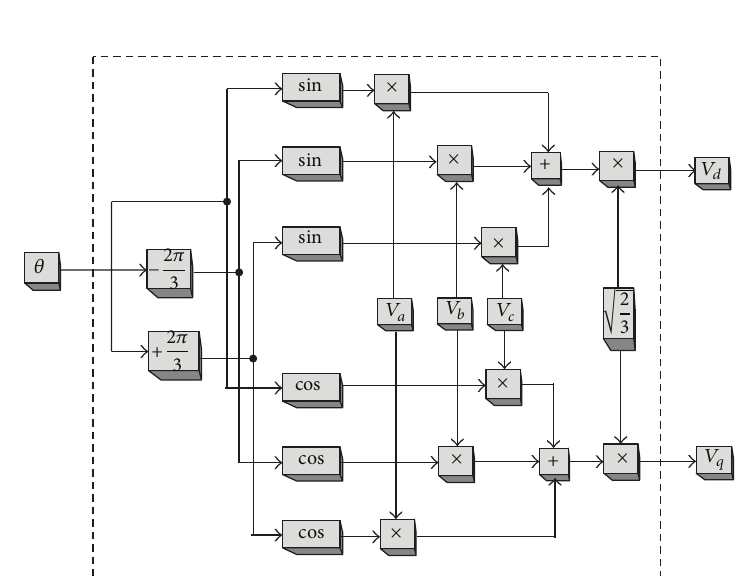
Figure 7: 𝑎𝑏𝑐/𝑑𝑞 -transform with type 1.